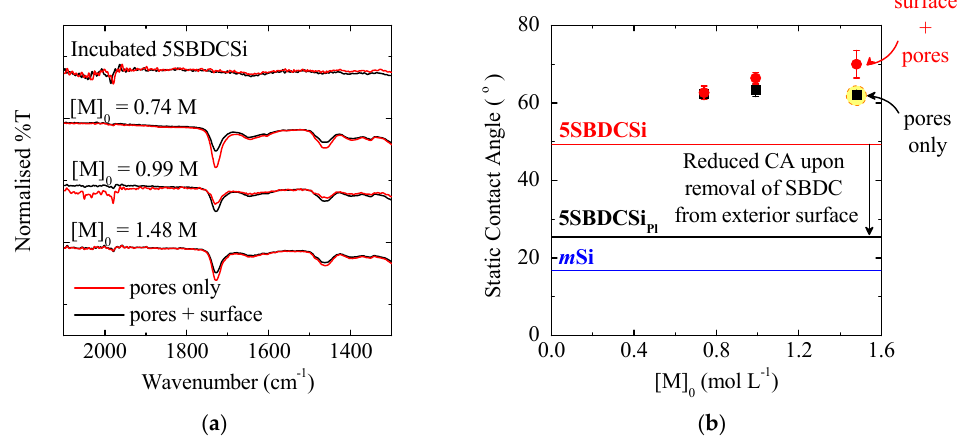
Figure 2. ( a ) IR; and ( b ) static CA measurements of mesoporous silica ( m Si) co-condensed with 5 mol % SBDC with (5SBDCSi Pl ) and without (5SBDCSi) a CO 2 plasma treatment prior to irradiation with